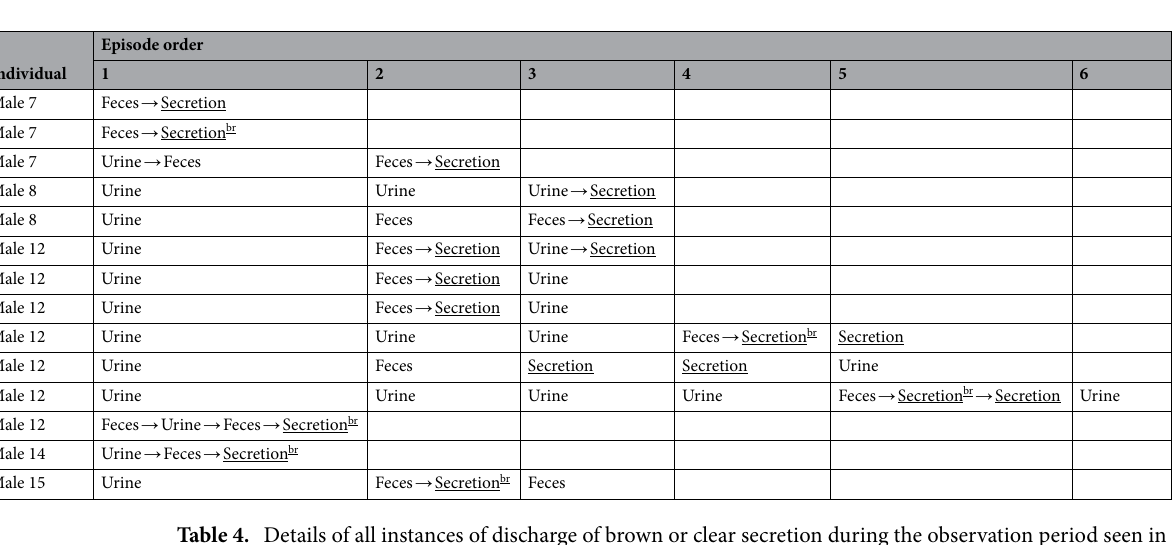
Table 4. Details of all instances of discharge of brown or clear secretion during the observation period seen in captive cheetahs. Brown secretion is indicated as Secretion br and clear secretion as